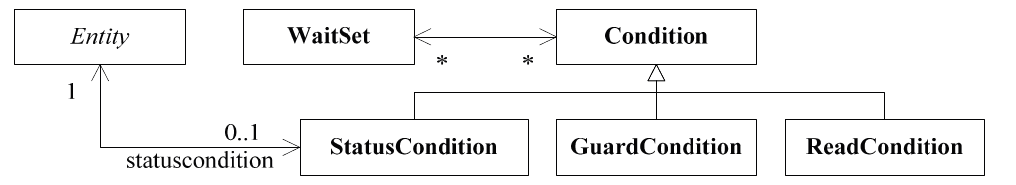
Figure 12. UML class diagram of the DDS elements involved in event management: conditions and